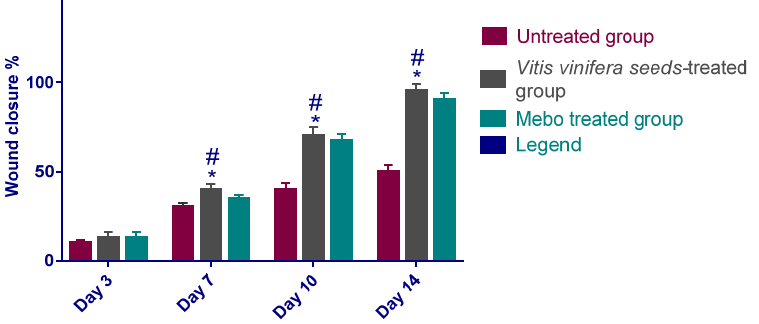
Figure 3. Wound closure percentages in tested groups; group 1: Untreated group (the positive control); group 2: V. vinifera seed-treated group; group 3: Mebo ® -treated group, over time post-injury (0, 3, 7, 10, and 14 days). Significant difference between groups is analyzed by a two-way ANOVA test. Data were expressed as mean ± SD. * p < 0.001 compared with the data of the untreated group on the respective day and # p < 0.001 in comparison with those of the Mebo ® group on the respective